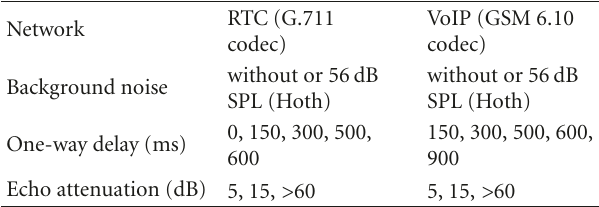
Table 4: Multiple linear regression analysis—training set (tests 1, 2, and 3).